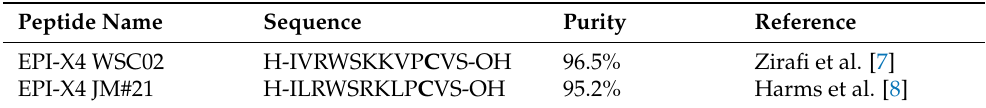
Table 1. Peptides used in this